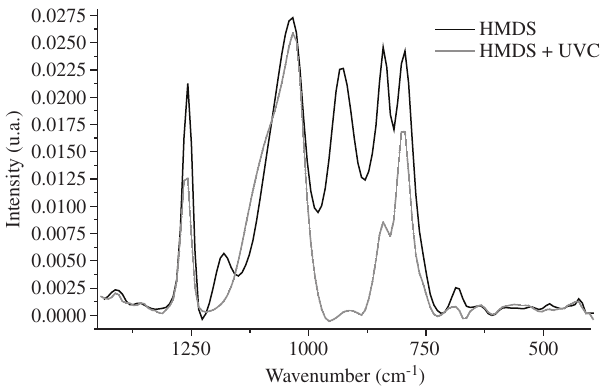
Figure 7. Infrared spectra of HMDS film before (solid line) and after eight days exposure to UVC (lighter